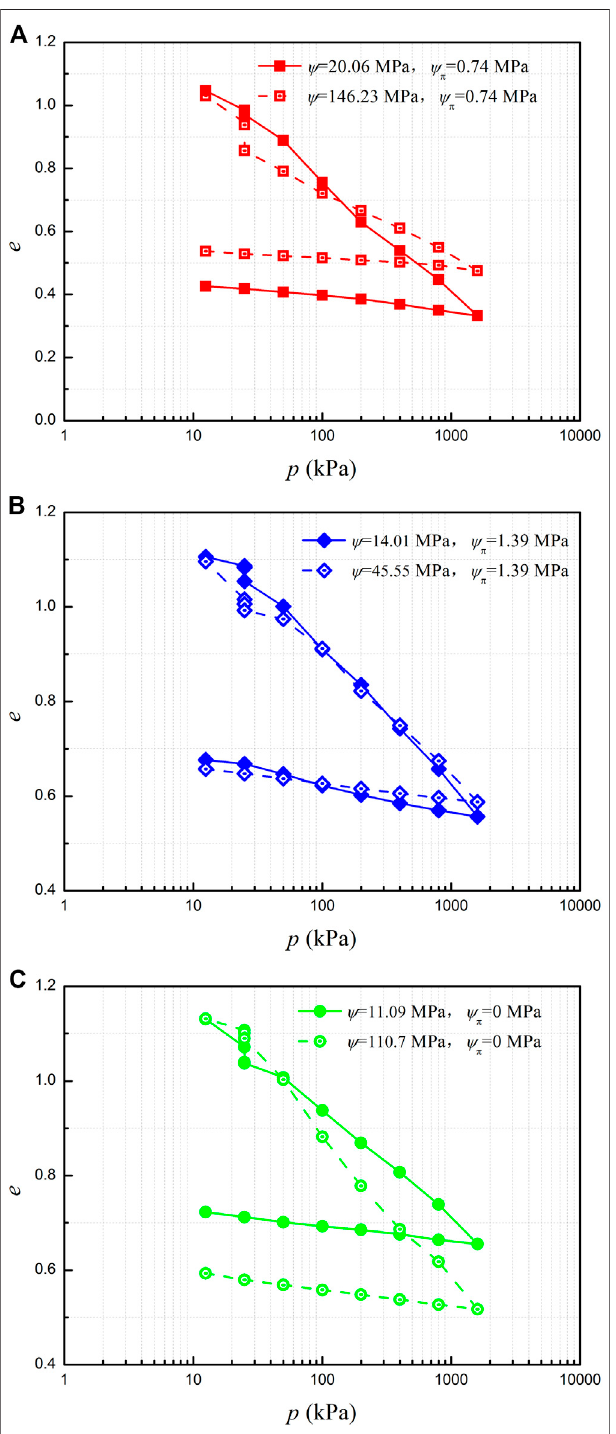
FIGURE 5 | The e -lg p curves of compacted loess under total suction and osmotic suction: (A) Ψ π = 0.74 MPa; (B) Ψ π = 1.39 MPa; (C) Ψ π = 0